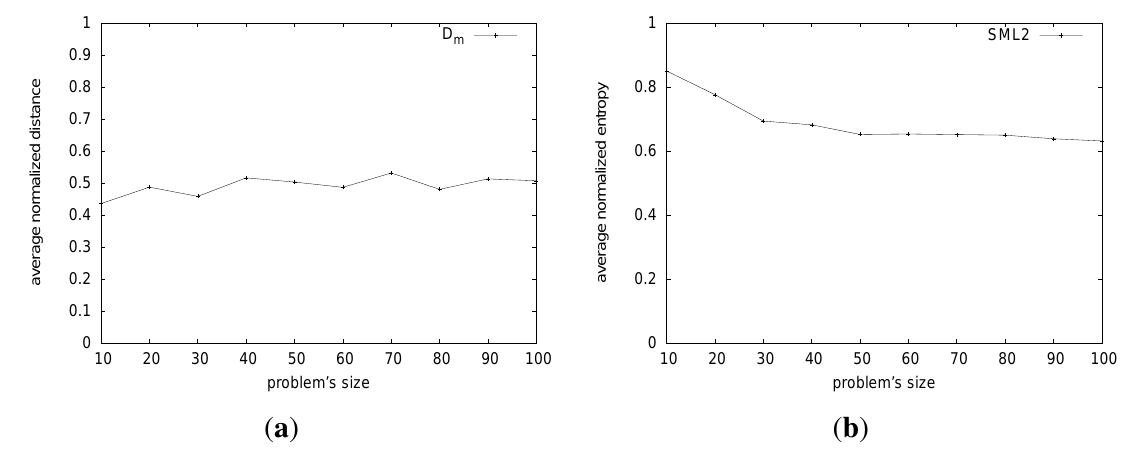
Figure 3. Sampling with SML2. ( a ) Average normalized distance D